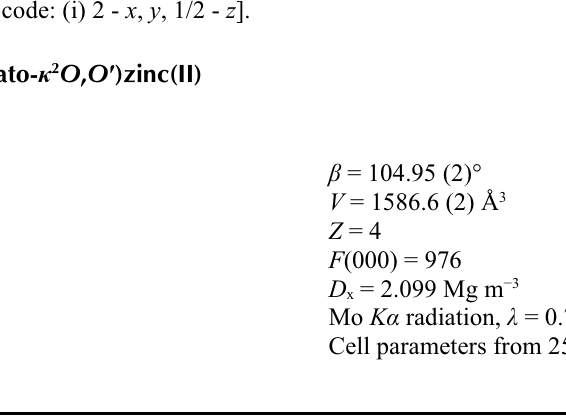
A drawing of the title molecule with the atom-numbering scheme. The displacement ellipsoids are drawn at the 50% probability level [symmetry code: (i) 2 - x , y , 1/2 - z